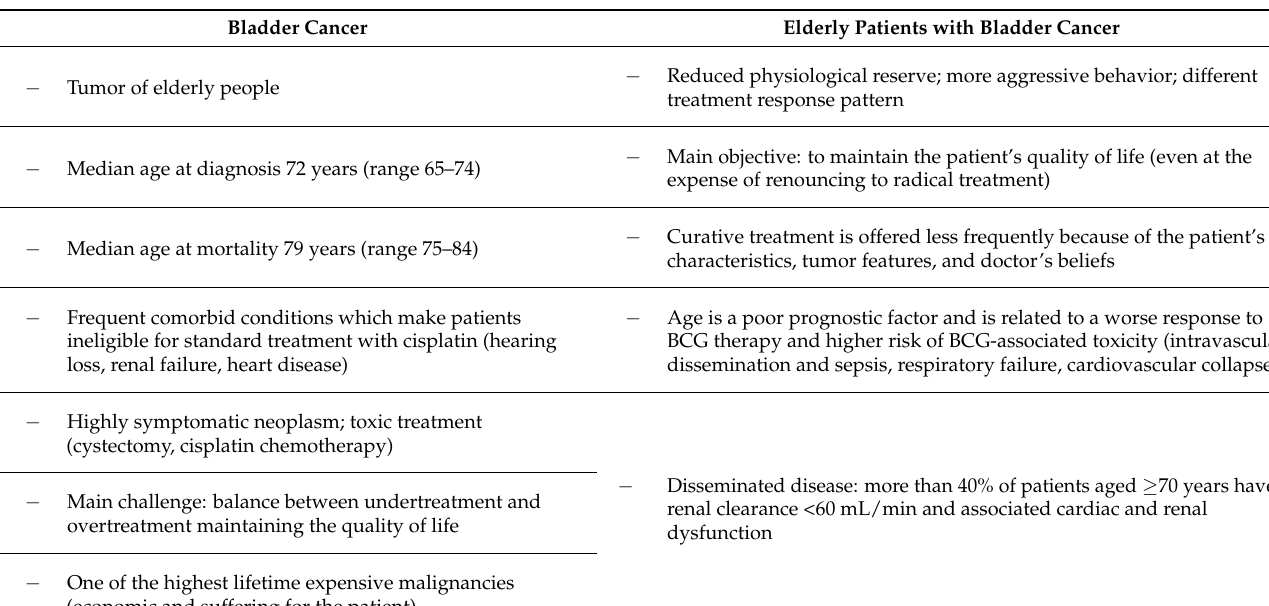
Table 4. Distinctive features of bladder cancer in elderly